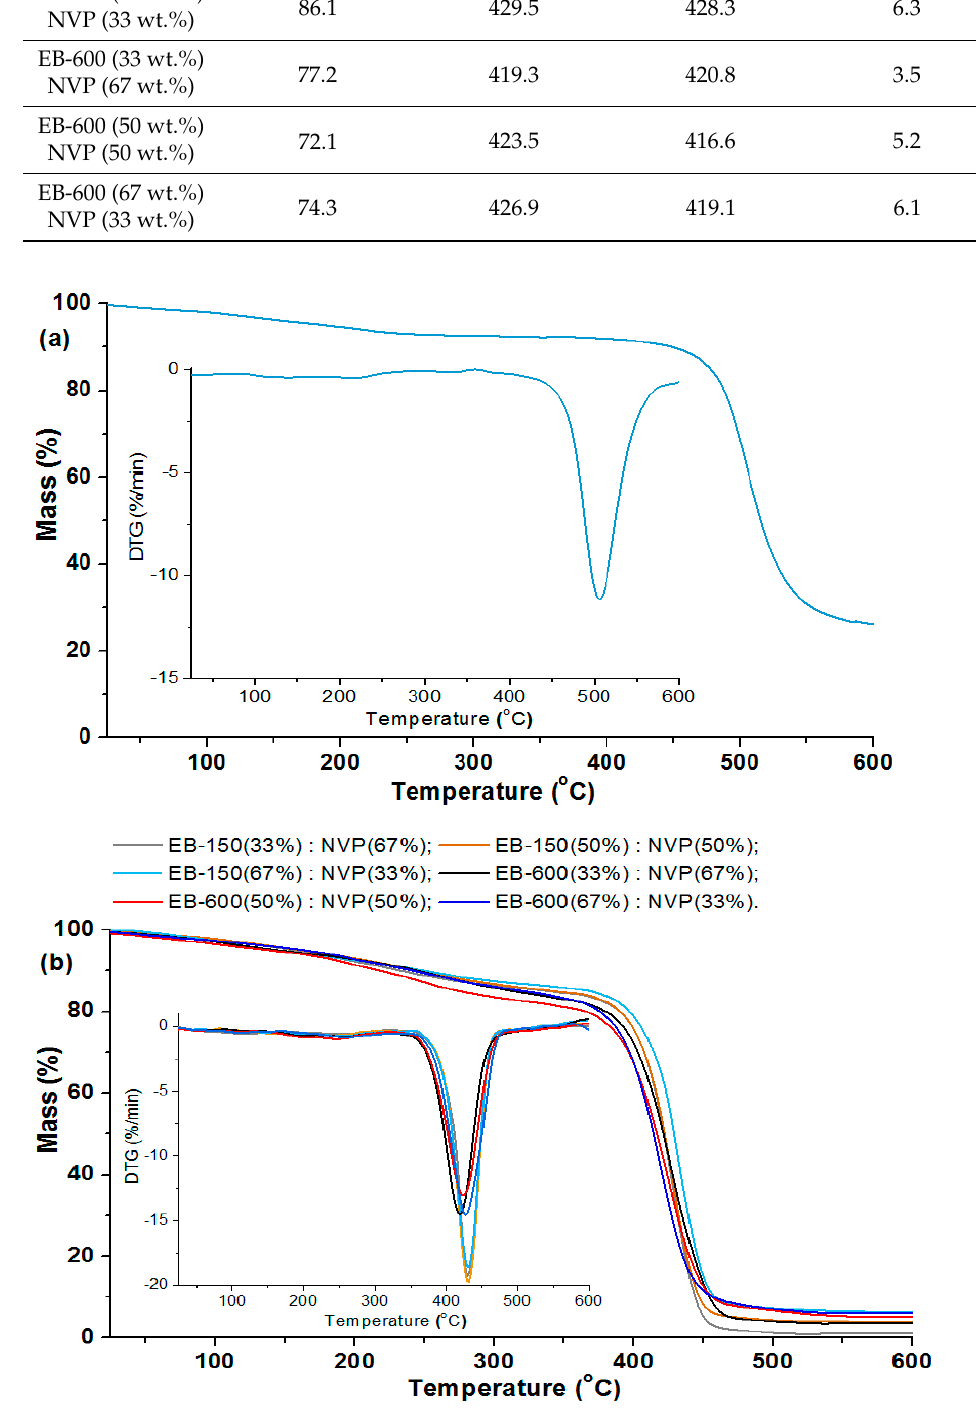
Figure 8. TG/DTG analysis of: ( a ) bisphenol Z polysulfone; ( b ) copolymers.